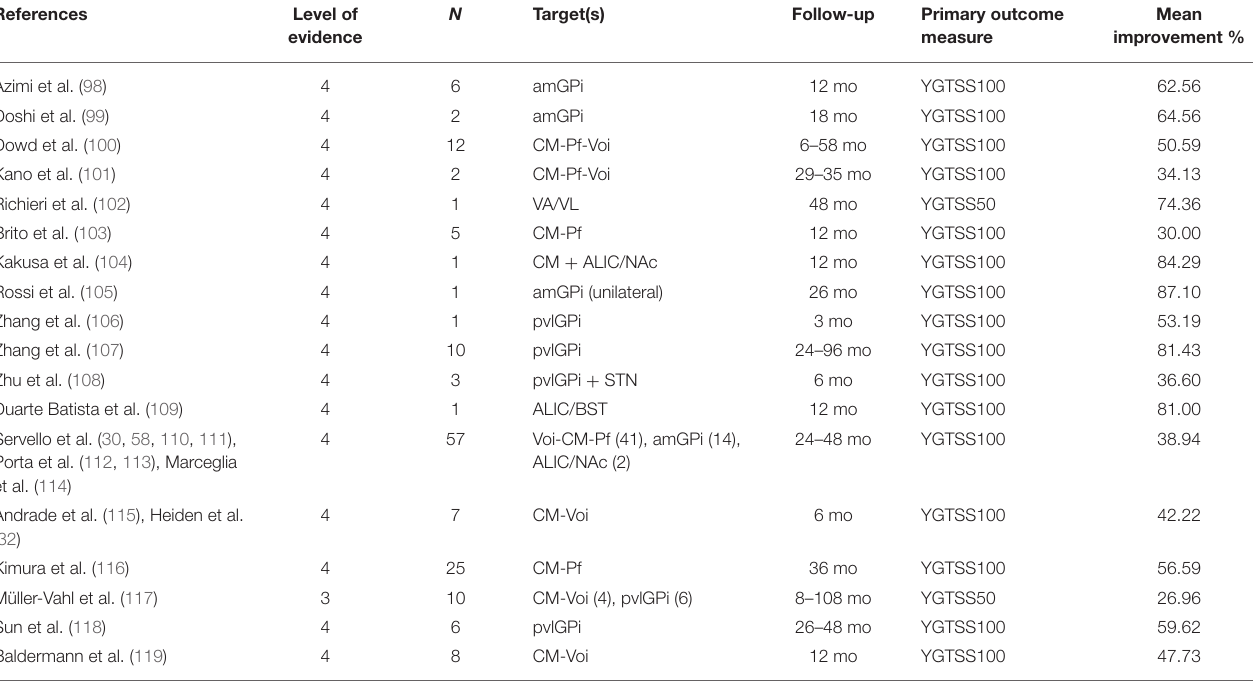
follow-up, which ranged from 3 to 49.5 months ( Mdn =